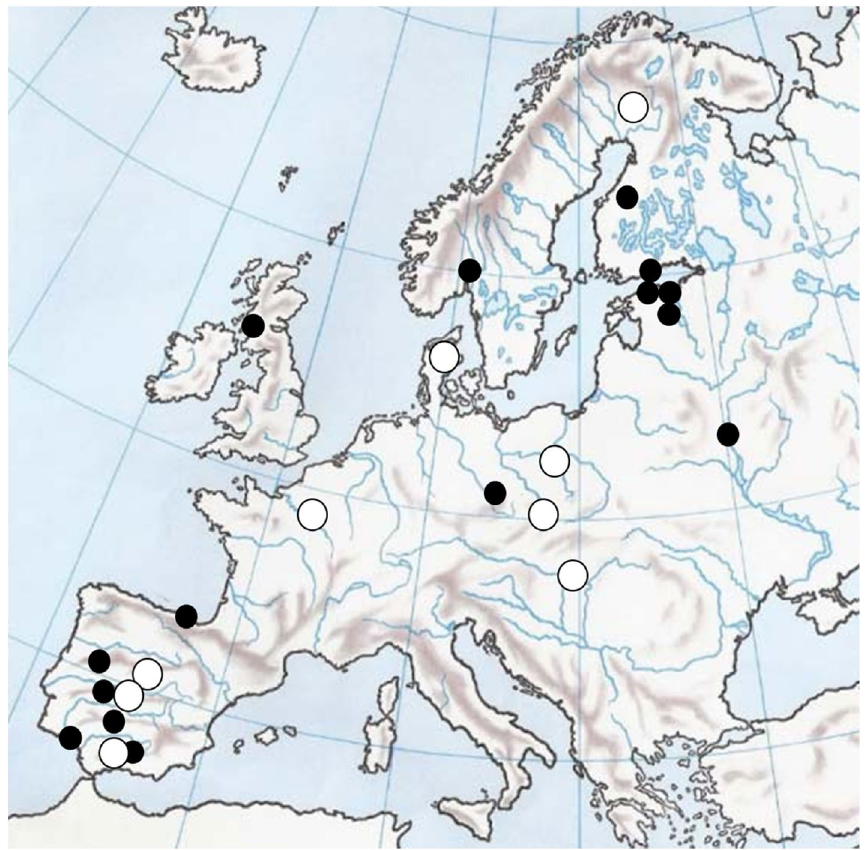
Figure 3. Location of the 24 study sites used for the study of flight initiation distance (FID) in Europe. Larger white spots indicate the nine study sites with more than 1000 FID records 13 . For latitudes and city names, see Supplementary Table S2. Map modified from https:// www. peque ocio. com/ wp- conte nt/ uploa ds/ 2018/ 04/ mama- mudo- fisico- europa- 768x5 51.